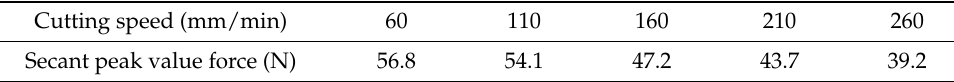
Table 1. Influence of cutting speed on the peak value force.